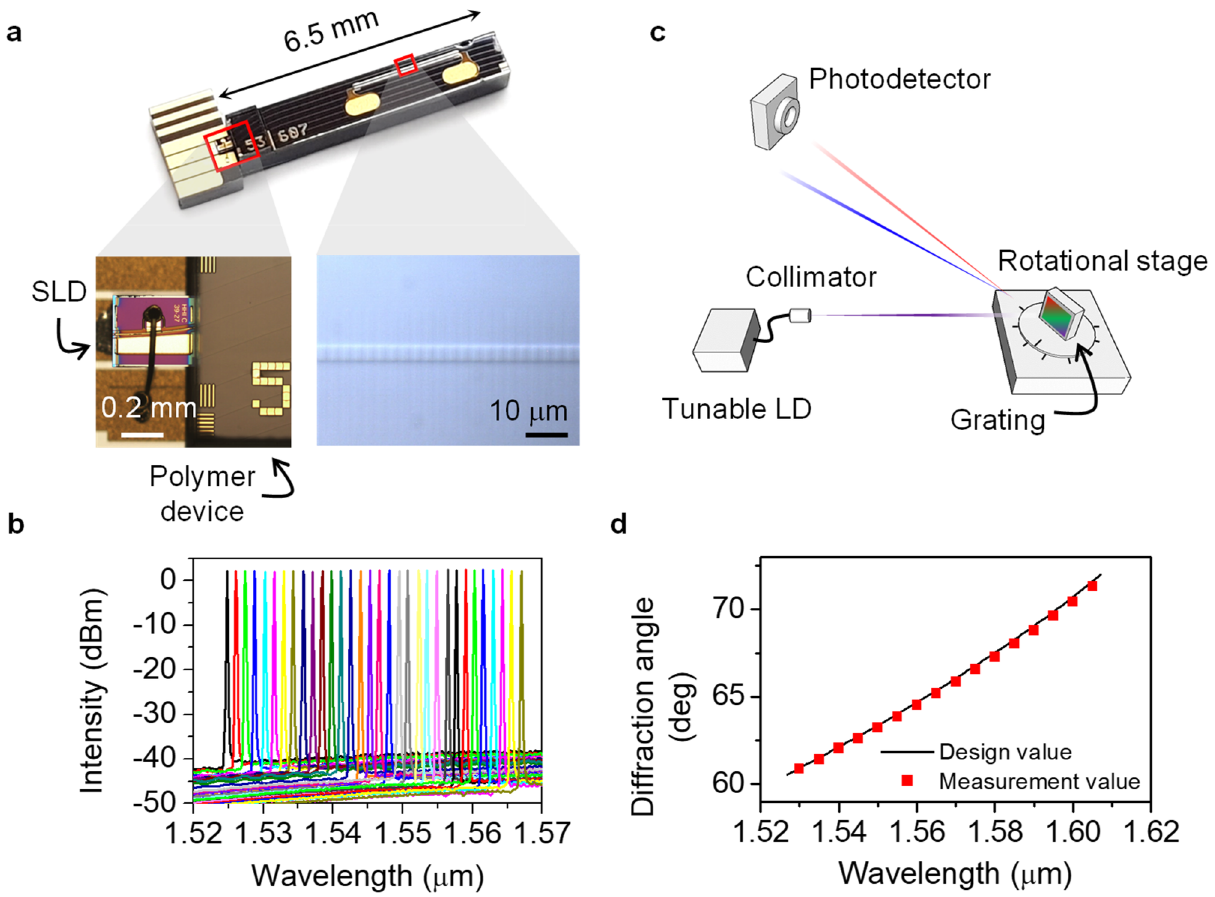
Figure 4. Polymer waveguide tunable laser and beam scanning through the blazed grating. ( a ) Tunable laser chip connected to the SLD chip to form an external cavity laser. ( b ) Output spectra obtained by wavelength tuning through heating the electrode of the polymer Bragg grating. ( c ) Experimental setup to measure the diffraction angle variation due to the wavelength tuning, where the laser output was incident at the Littrow angle of the blazed grating. ( d ) Diffraction angles depending on the tuned wavelength, where 14.7° scanning was obtained for 95 nm wavelength